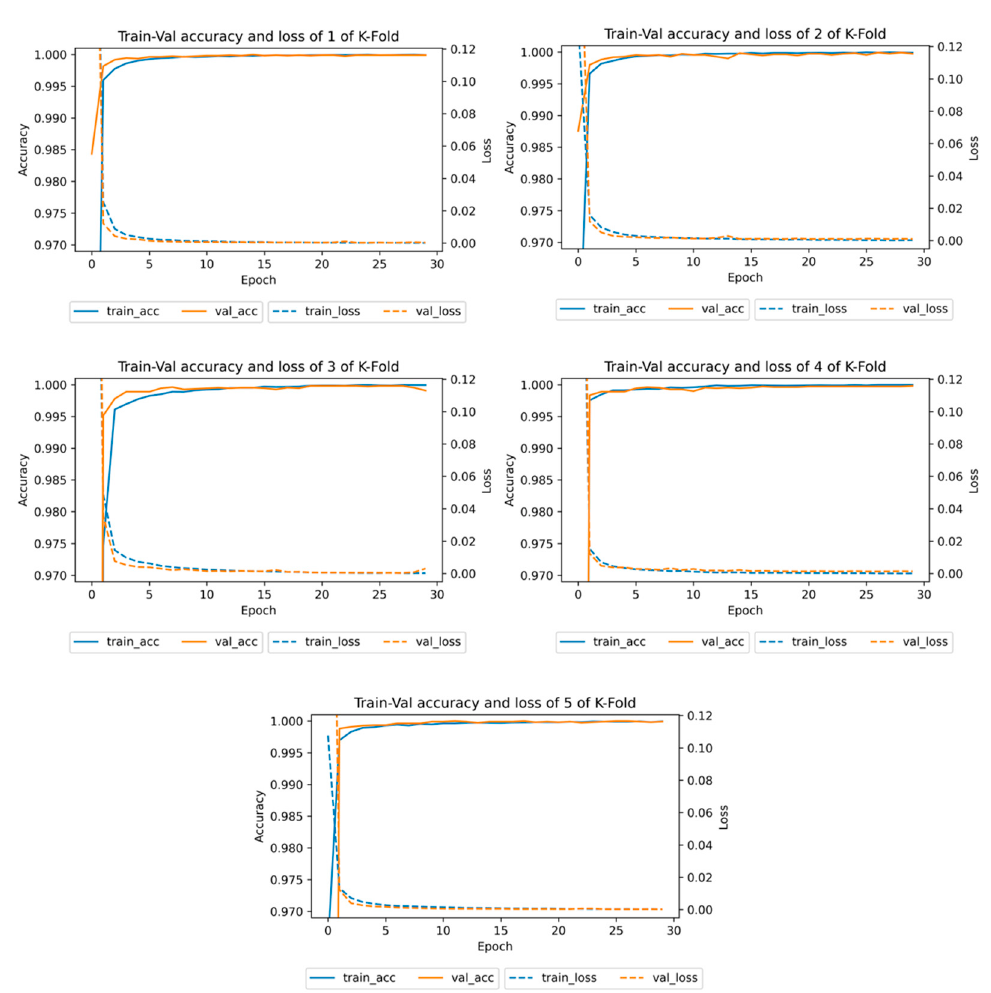
Figure 9. Accuracy and loss of five divisions of cross-validation dataset of the proposed network during training and validation.